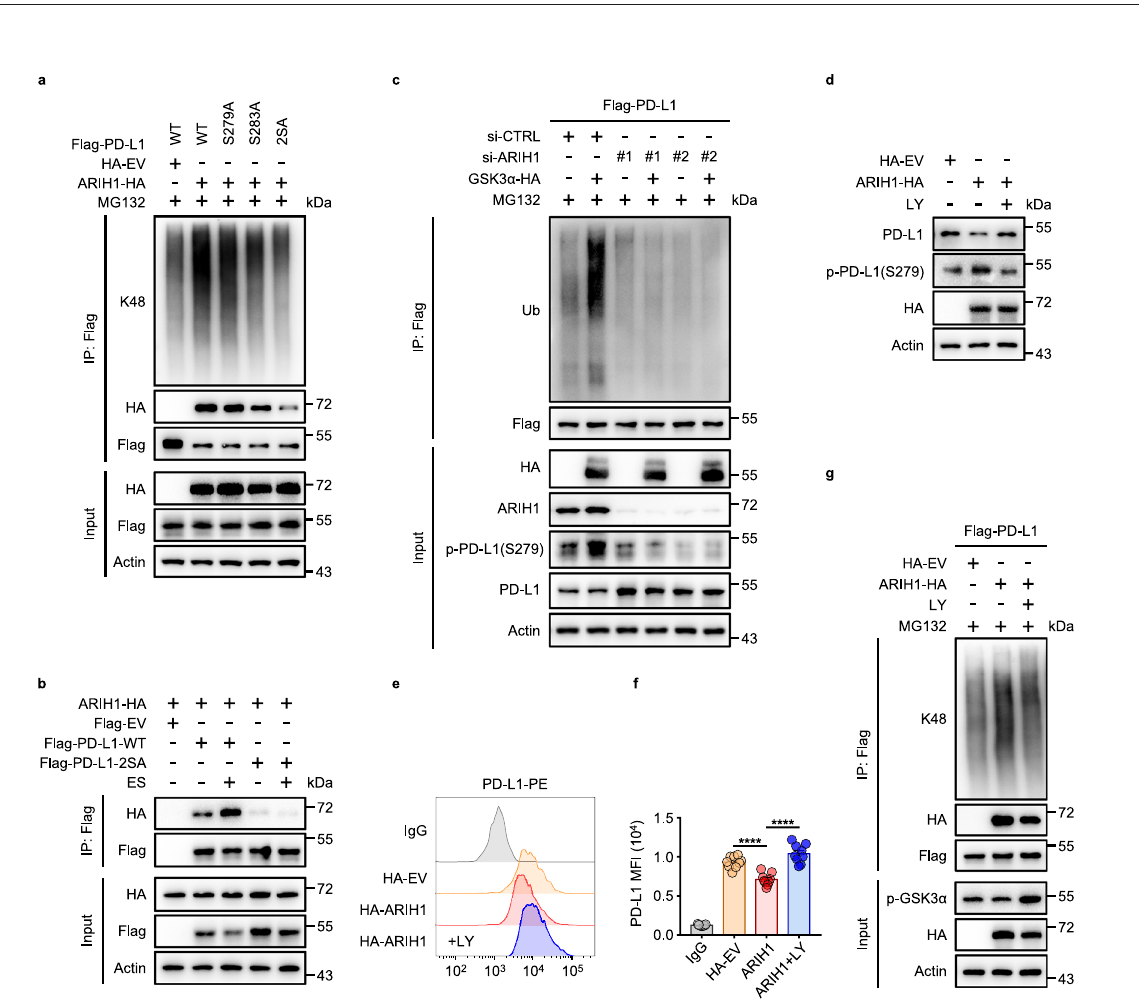
Fig. 5 GSK3 α -mediated phosphorylation of PD-L1 promotes PD-L1-ARIH1 interaction and ARIH1-induced degradation. a Co-IP analysis for the interaction of K48-ubiquitin, ARIH1 (HA), and PD-L1 in HEK293T cells transfected with HA-ARIH1 and Flag-PD-L1 (WT, S279A, S283A, or 2SA), treated with MG132 (10 μ M) for 6h; HA-tagged empty vector (HA-EV) was transfected as a negative control. b Co-IP analysis for the interaction of ARIH1 and PD-L1 in HEK293T cells transfected with HA-ARIH1 and Flag-PD-L1 (WT or 2SA), treated with 10 μ M ES-072 for 24h, Flag-tagged empty vector (Flag-EV) was transfected as a negative control. c HEK293T cells were transfected with Flag-PD-L1. Co-IP analysis for the interaction of ubiquitin and PD-L1 in HEK293T cells transfected with ARIH1- siRNAs or HA-GSK3 α and treated with MG132 (10 μ M) for 6h; non-targeting siRNA (si-CTRL) was transfected as a negative control. d Immunoblots of PD-L1 and ARIH1 (HA) in H1975 cells transfected with HA-ARIH1, treated with or without 5 μ M LY for 6h. e , f MFI ( e ) and relative quanti fi cation ( f ) of PD-L1 in HA-ARIH1- overexpressed H1975 cells, treated with or without 5 μ M LY for 6h. Data represent means±SEM, n = 9, 3 independent repeats, **** P <0.0001. g HEK293T cells were transfected with Flag-PD-L1. Co-IP analysis for the interaction of K48-ubiquitin, ARIH1 (HA), and PD-L1 in HEK293T cells transfected with HA-ARIH1, treated with or without 5 μ M LY for 12h and treated with MG132 (10 μ M) for 6h. Source data are provided as a Source Data fi